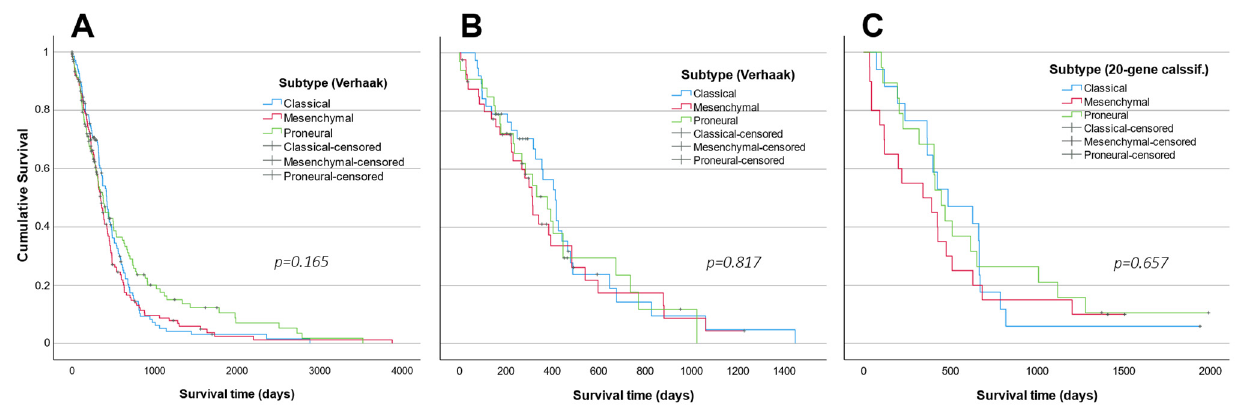
Figure 7. Kaplan–Meier survival curves of ( A ) the Affymetrix HG and ( B ) the Illumina HiSeq patients classified into three groups according to the Verhaak system and ( C ) the LUHS cohort survival curves classified into three groups applying the developed 20-gene classifier.